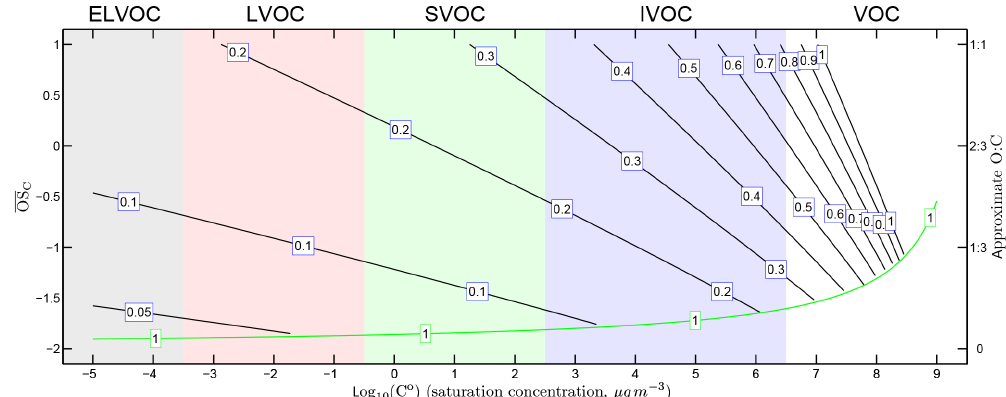
Figure 1. Atomic N:C ratio isopleths in the organonitrate layer of the 2D-VBS. The volatility space is divided into regions of organic compounds: extremely low volatility (ELVOC), low volatility (LVOC), semi-volatile (SVOC), intermediate volatility (IVOC), and volatile (VOC). Most organonitrate aerosols will have an N:C ratio lower than 0.2. The green line represents the single oxygen isopleth under which no organonitrate exists, because organonitrates themselves contribute an oxygen to the O:C